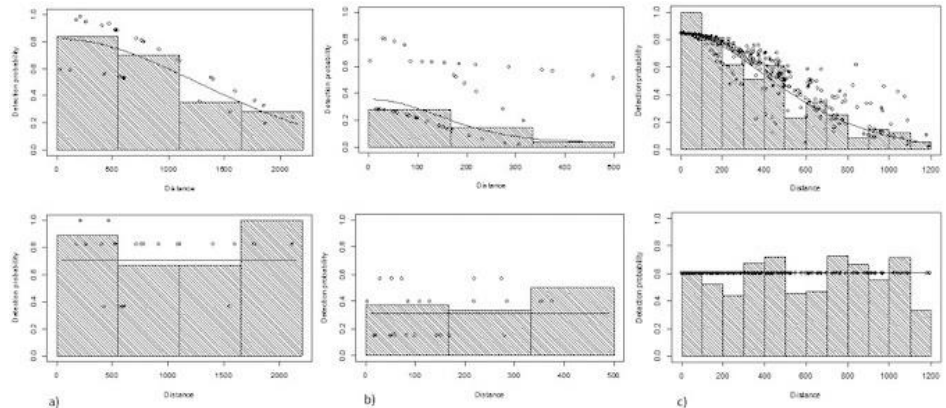
Figure 10. 2008 – 2013 survey detection function curves for pooled detections (top) and the conditional detection probabilities of platform 1 (bottom) for killer whales (a), harbour porpoises (b), and Lagenorhynchus spp. (c).